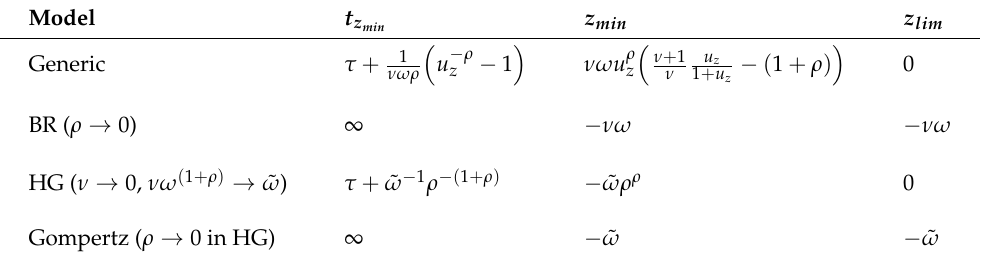
Table notes: BR, Bertalanffy–Richards; HG, Hyper-Gompertz; ϕ t is as defined in (2) and z t is available from Table A1, u z = ( (cid:112) 1 − ρ 0 − 1 ) / (cid:112) 1 − ρ 0 with ρ 0 = ν ( ρ + 1 ) / ( ν + 1 )